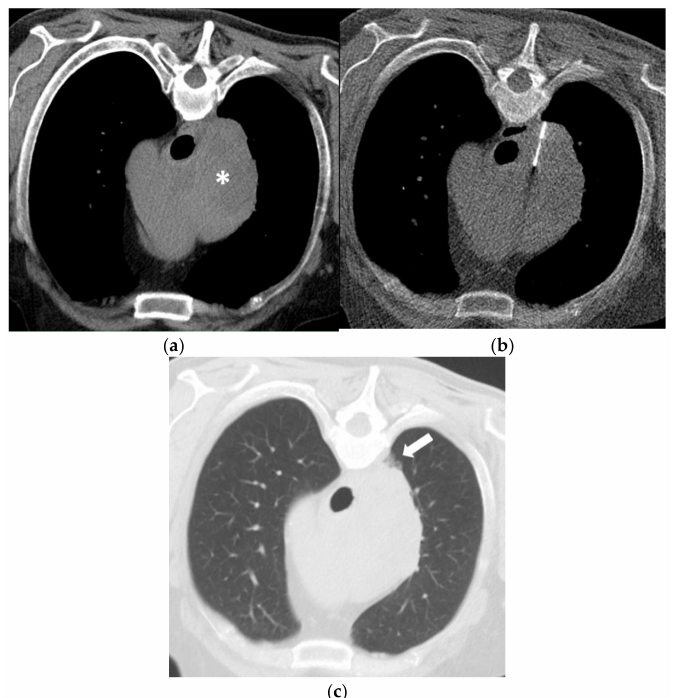
Figure 2. ( a ) A 60-year-old man with a history of Diffuse Large B-Cell Lymphoma (DLBCL) and missing response to CHOP chemotherapy. Unenhanced CT in prone position before biopsy shows a large right mediastinal mass (asterisk). ( b ) Using a right paravertebral transpulmonary access under CT fluoroscopy guidance, an 18-Gauge Tru-Cut biopsy needle is inserted into the mass. Histopathology confirmed a DLBCL (germinal-center-b-cell-like type). ( c ) Unenhanced CT after the biopsy depicts a small alveolar hemorrhage (arrow) without signs of a pneumothorax.